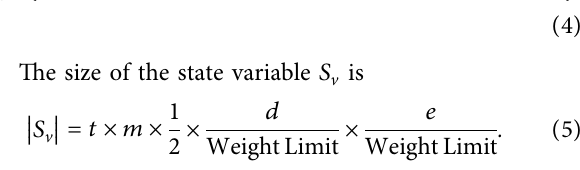
Figure 3: Map 3. Table 6: Parameter setting.